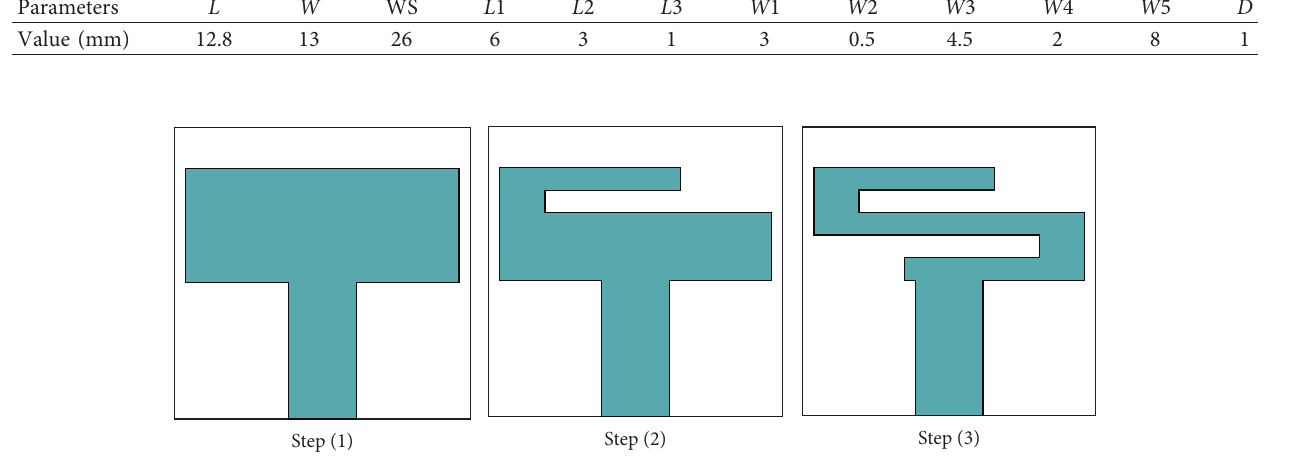
Figure 2: Design evolution of the proposed antenna.